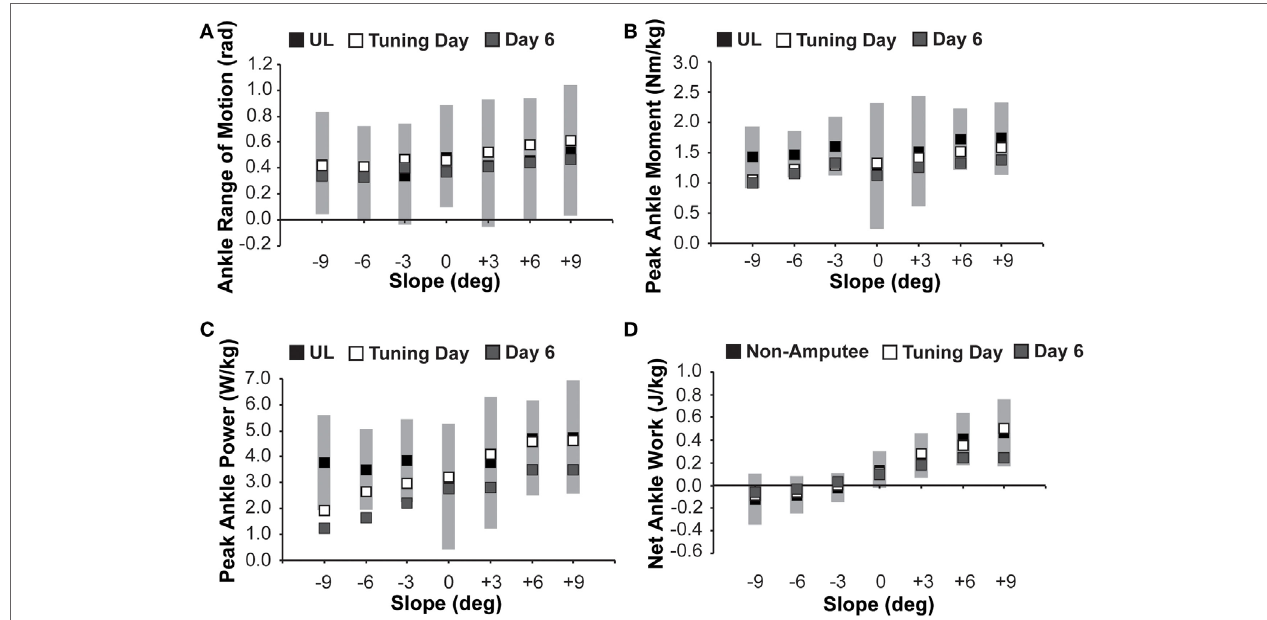
FigUre 2 | Prosthetic ankle (a) range of motion, (B) peak moment, (c) peak power, and (D) net work from the iterative BiOM tuning process for subjects walking at 1.25 m/s over a range of slopes. We tuned the BiOM to match average unaffected leg (UL) data (black) within 2 SDs (gray shaded area) for ankle (a) range of motion, (B) peak moment, and (c) peak power. We tuned the BiOM to match average data from non-amputees (black) within 2 SDs for ankle (D) net work. BiOM prosthetic ankle data (ensemble average) collected at the end of the tuning day (white) were numerically higher (closer to UL and non-amputee data) for most biomechanical variables at all slopes compared to the final day of the protocol (gray). We used data collected on Day 6 for analyses. In some cases, the symbols